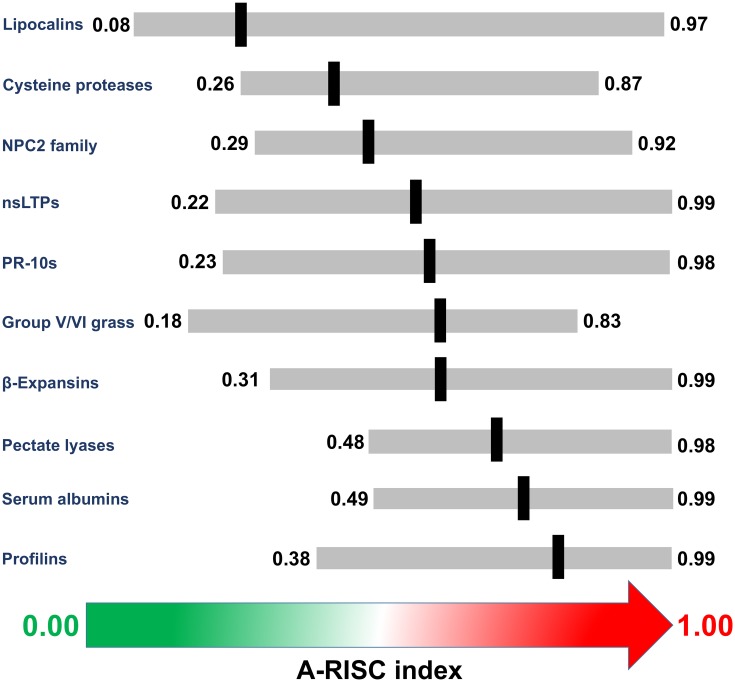
A-RISC indexes for various allergen families.Gray bars correspond to observed A-RISC ranges. The black horizontal lines indicate an average A-RISC index for a family.